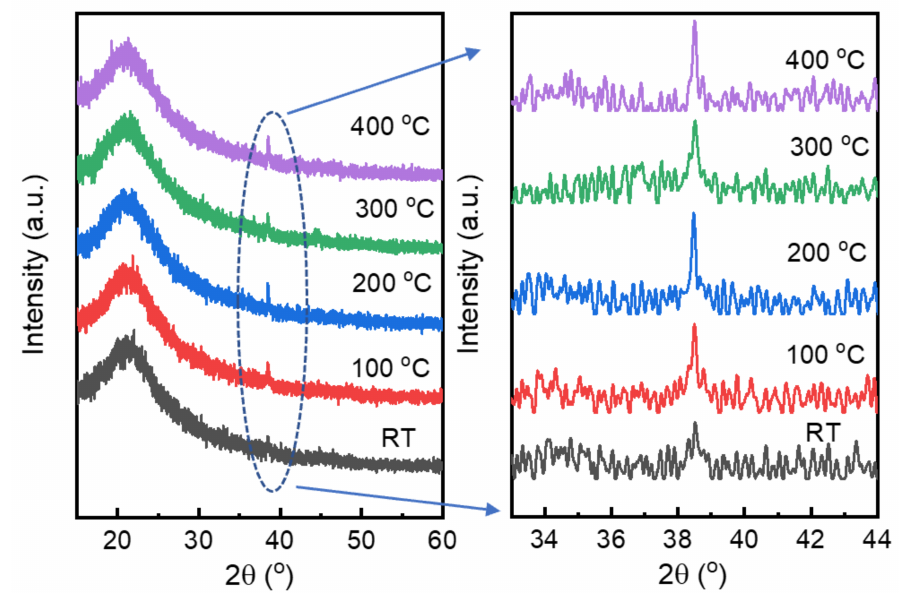
Figure 2. XRD pattern of the Al film at different deposition temperatures.